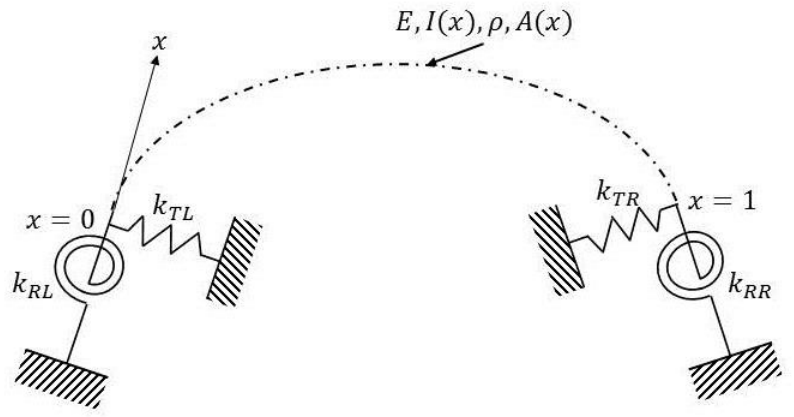
Figure 3. Scimitar-type curved beam with rotational and translational flexible ends.